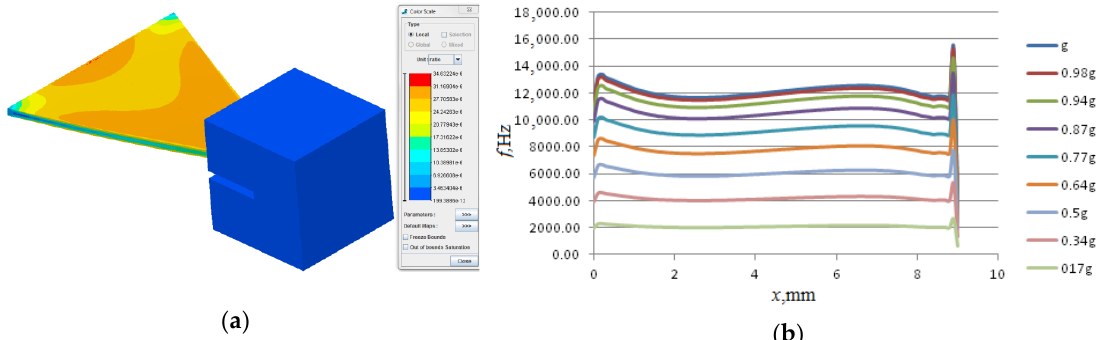
Figure 5. Surface acoustic wave solid-state accelerometer (SSA) with a triangular-shaped sensitive element (SE): ( a ) — simulation results of the linear acceleration influence on the characteristics of SE of SSA on SAW with triangular console shape; ( b ) — the distribution of relative deformations along the central longitudinal axis.